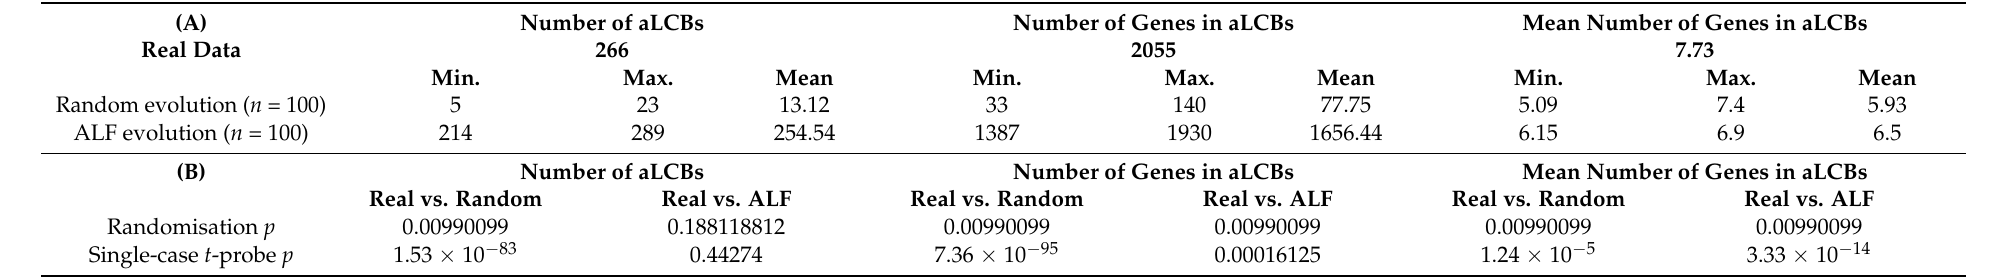
Table 1. Comparison of the real and simulated values of the aLCB parameters. ( A ) The table show the differences between the real and the two distinct simulated datasets. ( B ) Statistical evaluations of the simulated datasets compared to the real